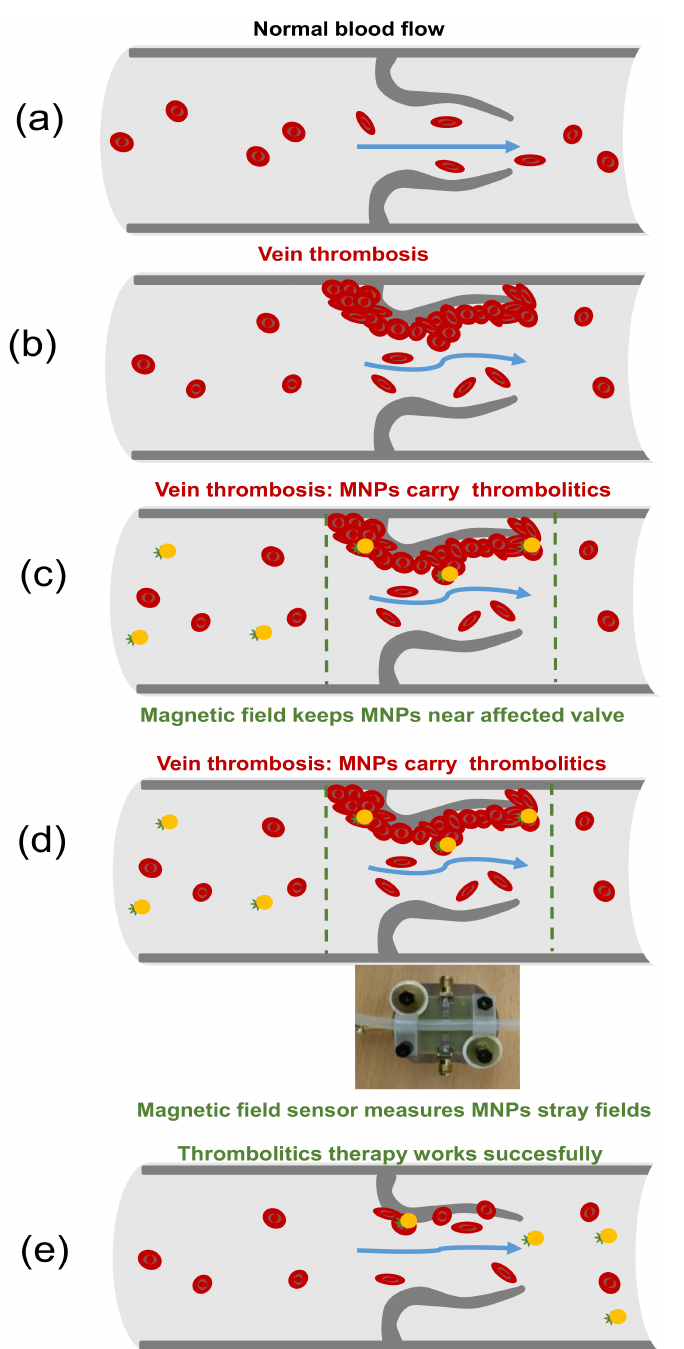
Figure 10. Schematic description of the normal blood flow in a vein ( a ) and blood flow near thrombo- sis affected vessel ( b ). Intravenous injection of magnetic particles carried on thrombotic drug and directed toward the therapy zone (indicated by vertical dashed lines) by gradient magnetic field ( c ). Magnetic field sensor evaluates the stray fields of magnetic particles accumulating in the therapy zone in a series of displacements measurements, which can be extended by periodic measurements of the response for evaluation of the particles concentration near the blood clot center ( d ). End of the therapy and particles removal ( e